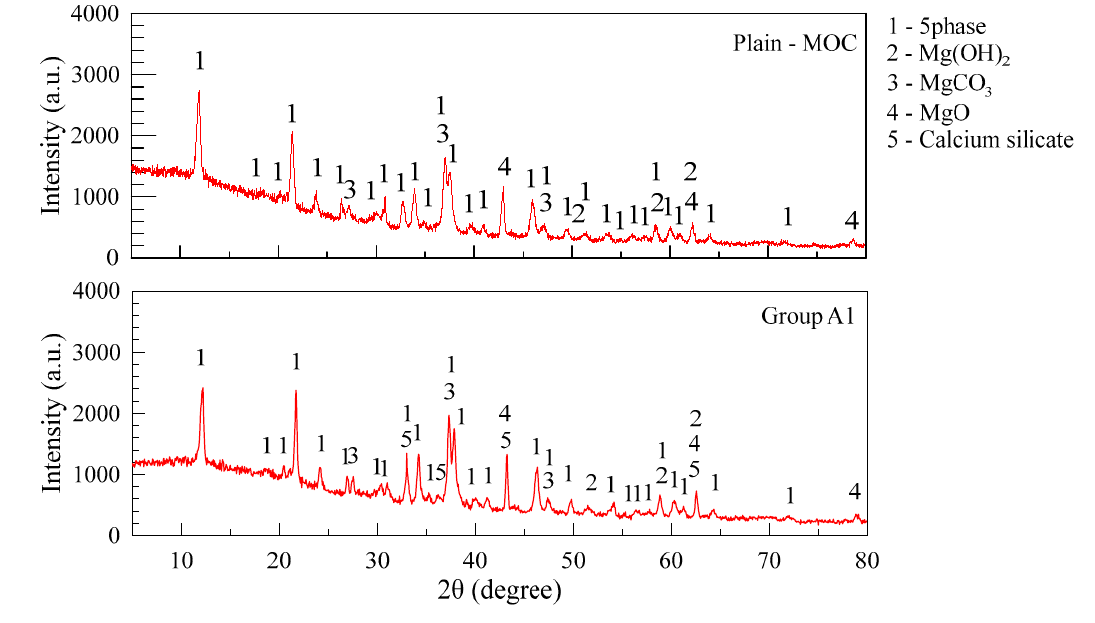
Figure 6. XRD curve of MOC sample.